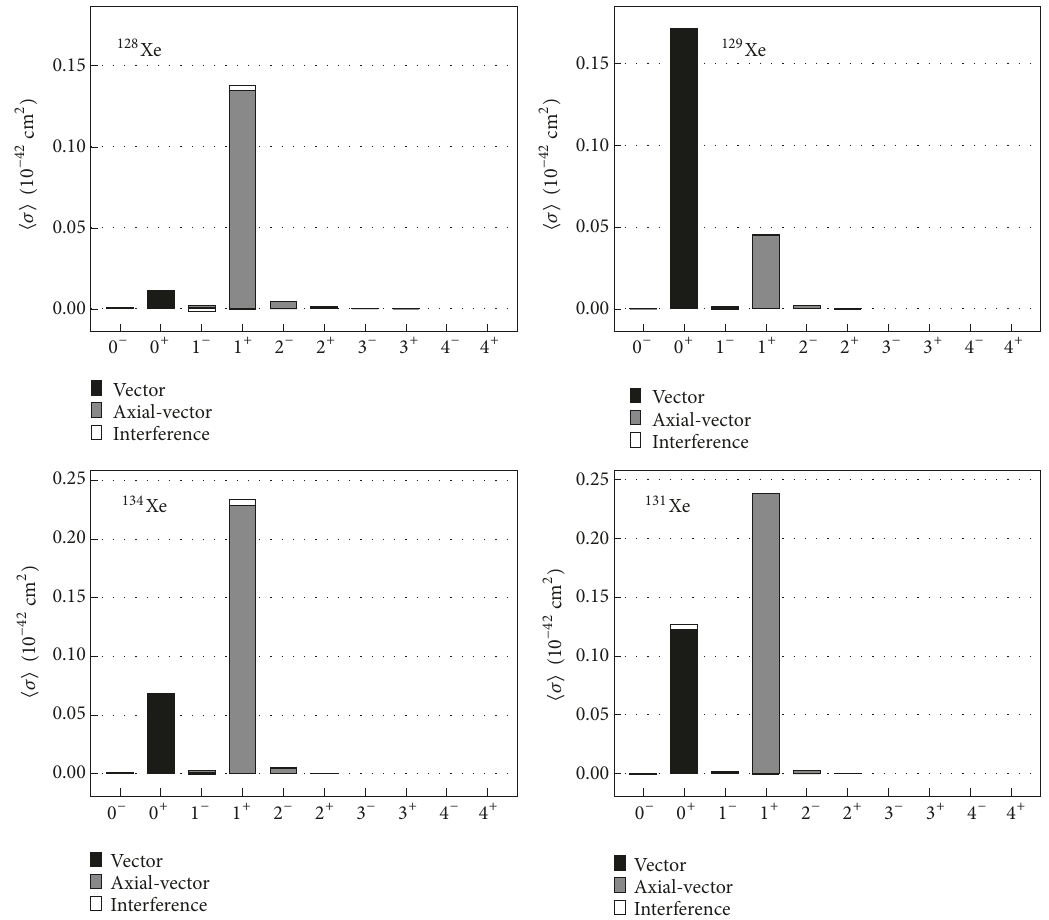
Figure 5: The contributions of multipole channels 𝐽 ≤ 4 to the total averaged cross section for inelastic scattering of solar 8 B neutrinos. Bar plots are shown for a representative sample of 128 Xe (top left), 129 Xe (top right), 134 Xe (bottom left), and 131 Xe (bottom right). A division to vector, axial-vector, and interference parts of the interaction is shown. Cross sections are given in units of 10 −42 cm 2